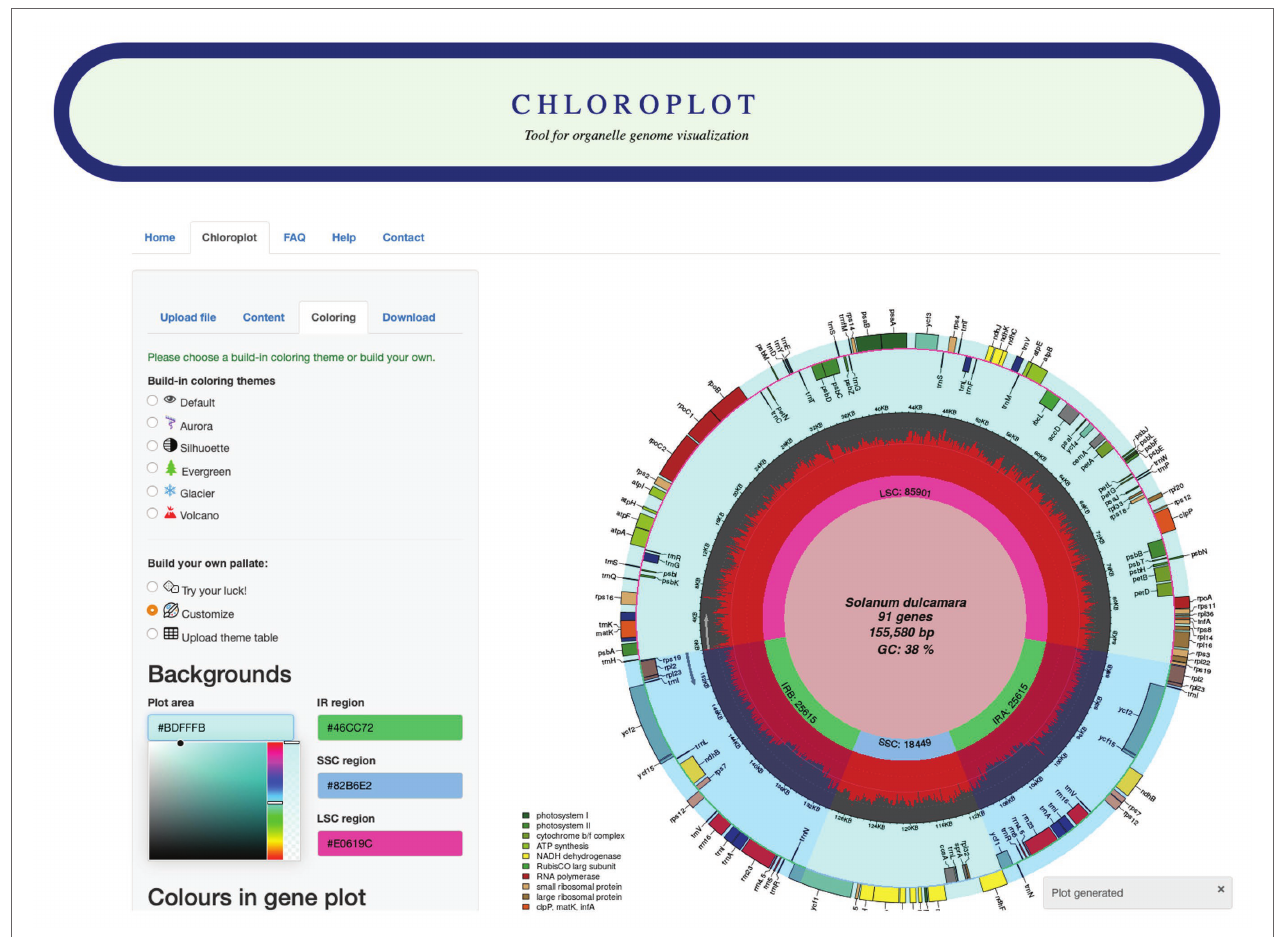
FIGURE 1 | Screenshot of the Chloroplot online web interface. Chloroplot gives vast control over the generated output with respect to the predefined color schemes and interesting genomic